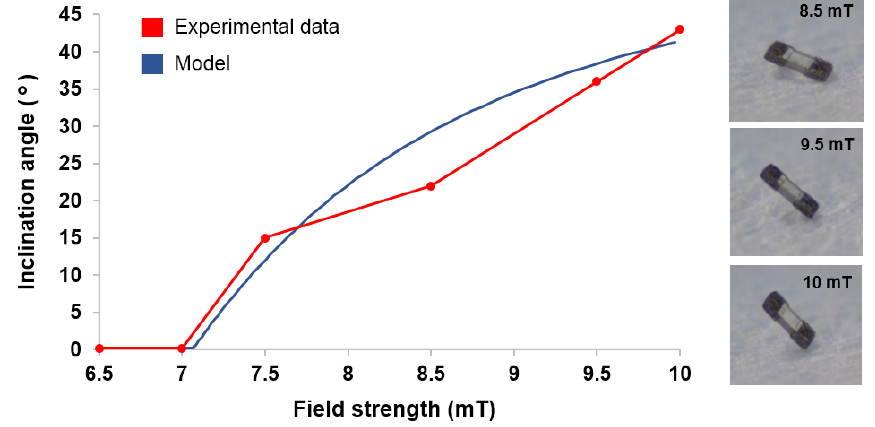
Figure 7. Model and experimental equilibrium orientation angle θ at varying field strengths (Results also shown in Supplemental Video